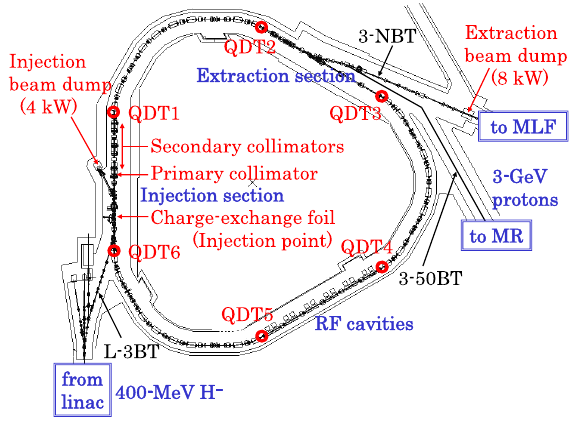
FIG. 1. Schematic view of the J-PARC 3-GeV